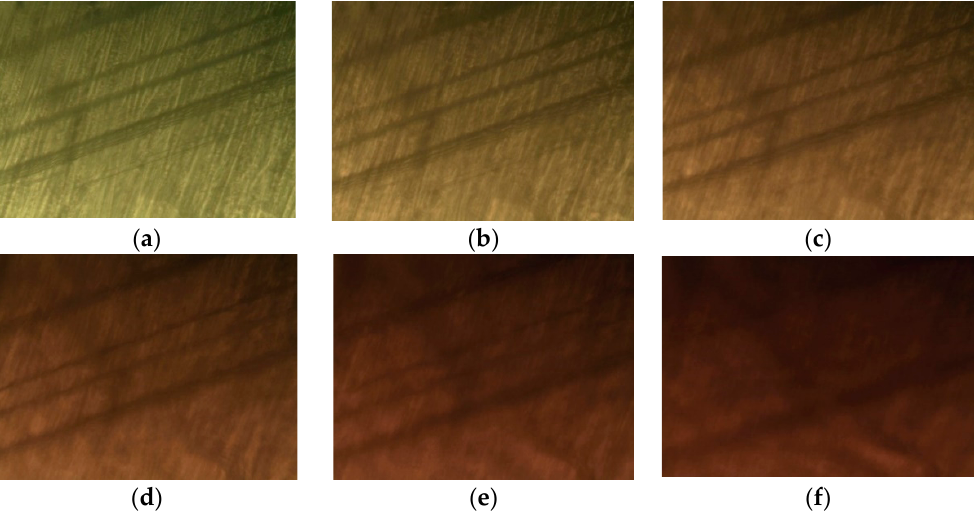
Figure 3. Optical polarizing microscopy images of [NH 3 (CH 2 ) 5 NH 3 ]CuCl 4 at ( a ) 300 K, ( b ) 340 K, ( c ) 360 K, ( d ) 390 K, ( e ) 420 K, and ( f ) 440 K. Parallel lines represent ferroelastic twin domain walls.